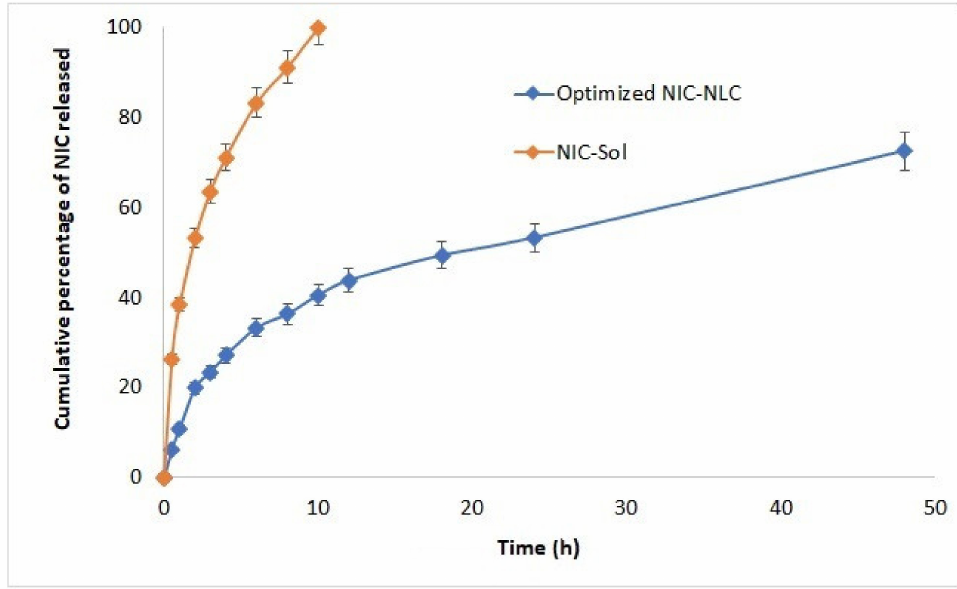
Figure 3. Release profiles of NIC from optimized NIC–NLC formulations (average release data of the three optimized NIC_NLC formulations was illustrated) in comparison to plain NIC in simulated nasal fluid (pH